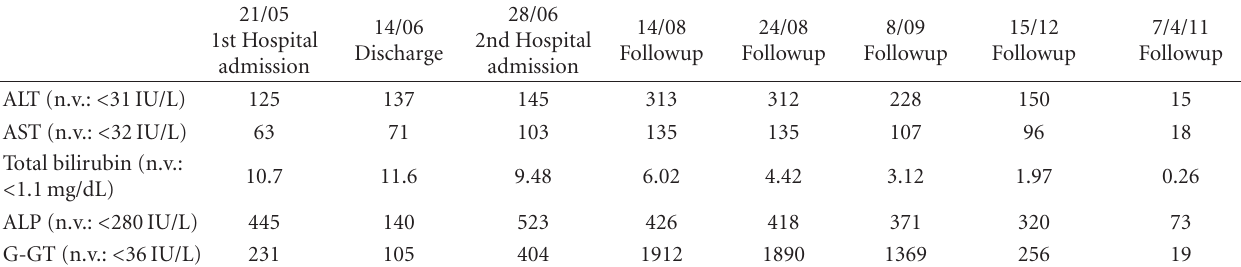
Table 1: Time course of liver function tests. ALT: alanine transaminase; AST: aspartate aminotransferase; ALP: alkaline phosphatase; G-GT: gamma-glutamyl transpeptidase; n.v.: normal values.